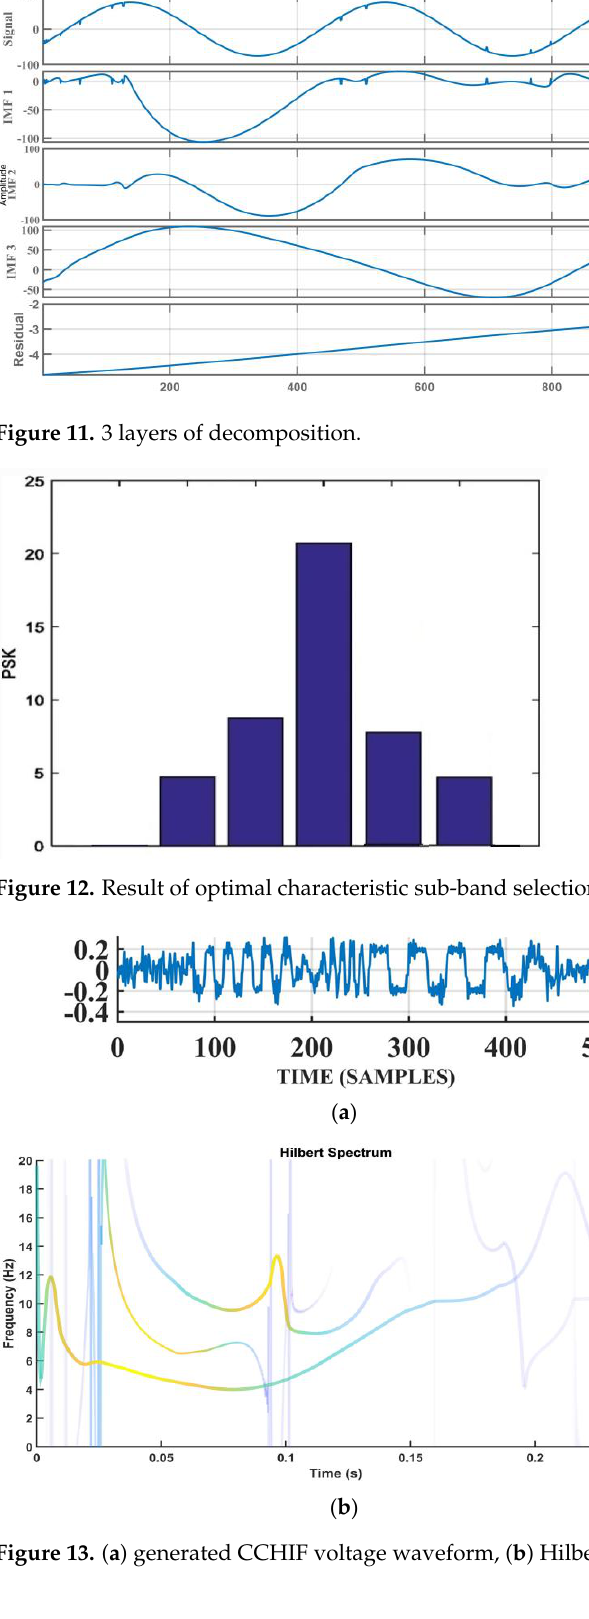
Figure 13. ( a ) generated CCHIF voltage waveform, ( b ) Hilbert Spectrum of CCHIF waveform.